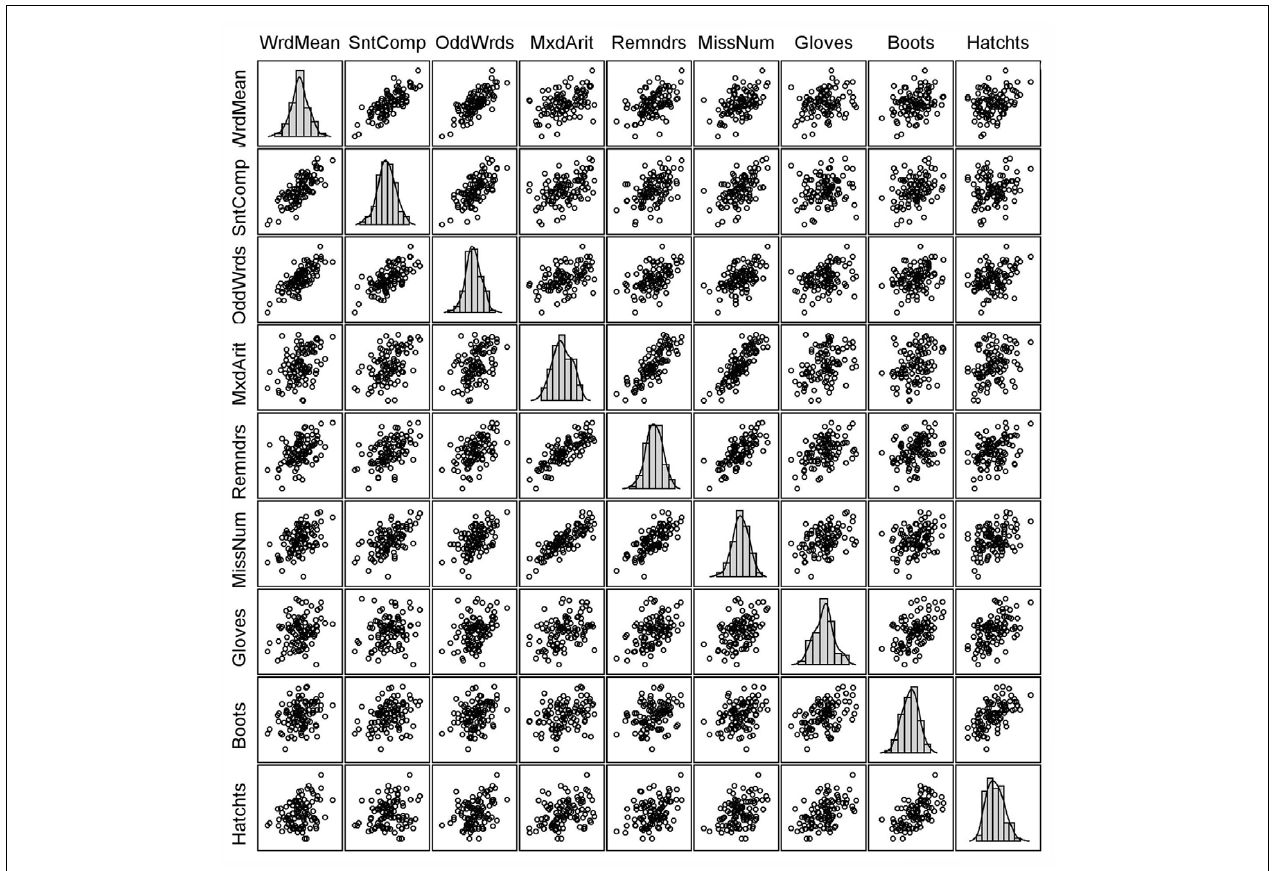
FIGURE 1 | Scatterplot matrix for multivariate normal random sample consistent with Holzinger data ( N = 100; no unusual